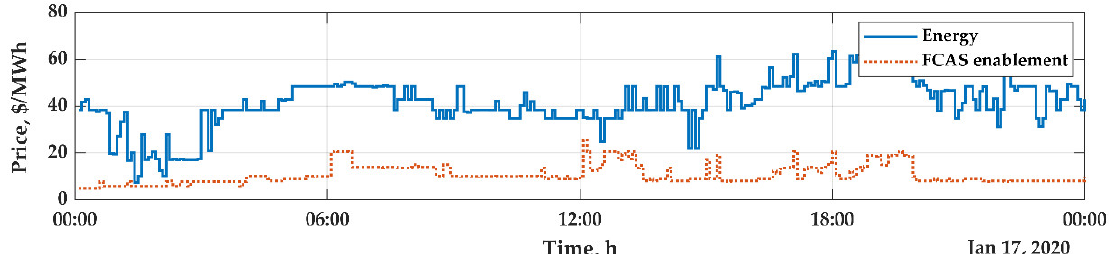
Figure 8. Example of energy spot price and 6 s raise contingency price over one day (NSW market).